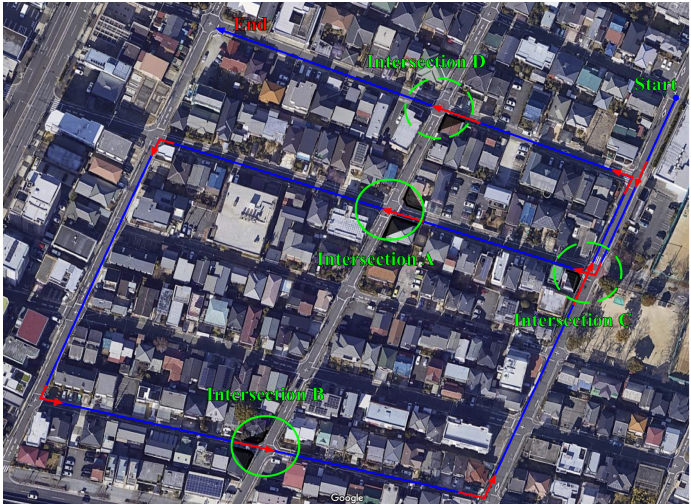
Figure 8. Experimental